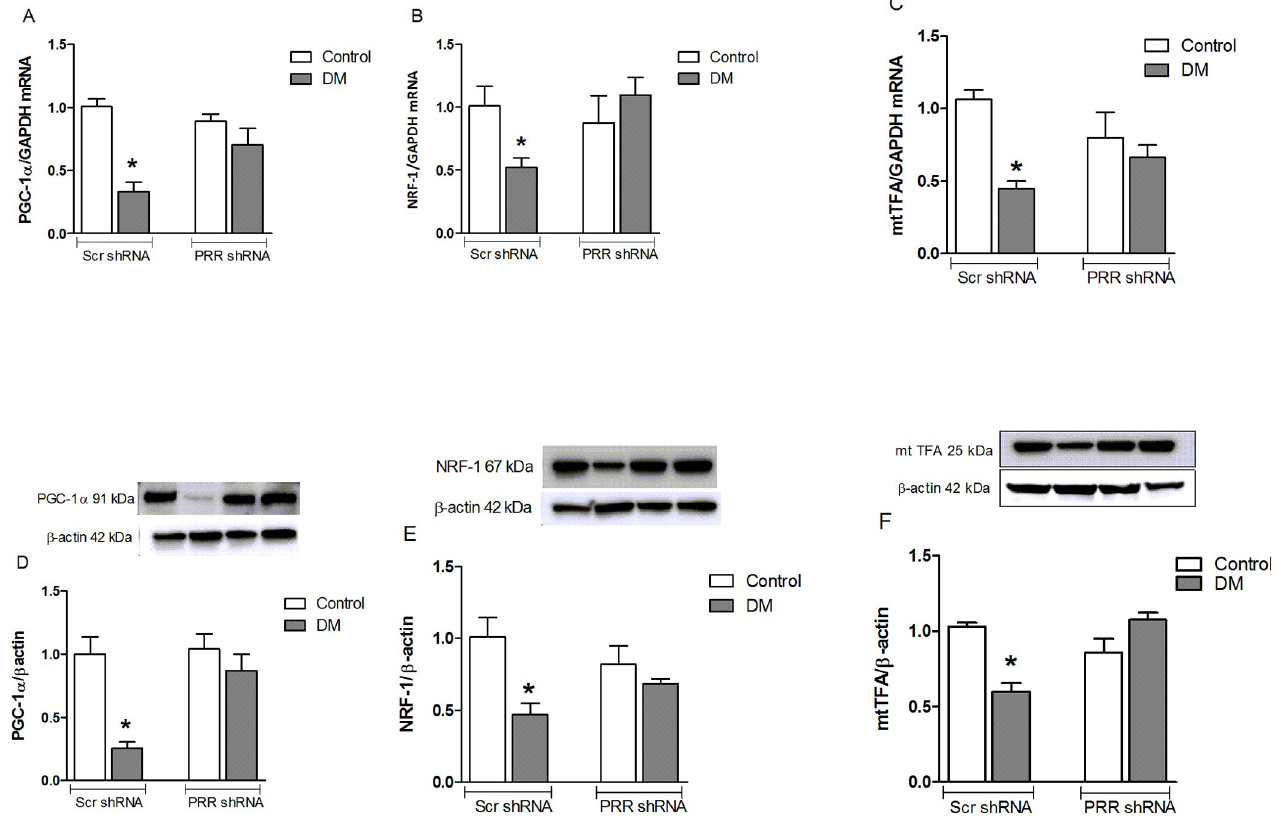
Fig 3. Renal expressions of PGC-1 α , NRF-1 and mtTFA. (A-C) mRNA and (D-F) protein expressions in normoglycemic control mice treated with scramble (Scr) shRNA (n = 6 each group), and streptozotocin (STZ)-induced diabetic mice treated with PRR shRNA (DM + PRR shRNA; n = 6 each group), after eight weeks of STZ-induction of diabetes. Data are mean ± SEM. � P < 0.05 vs. Veh + Scr shRNA.